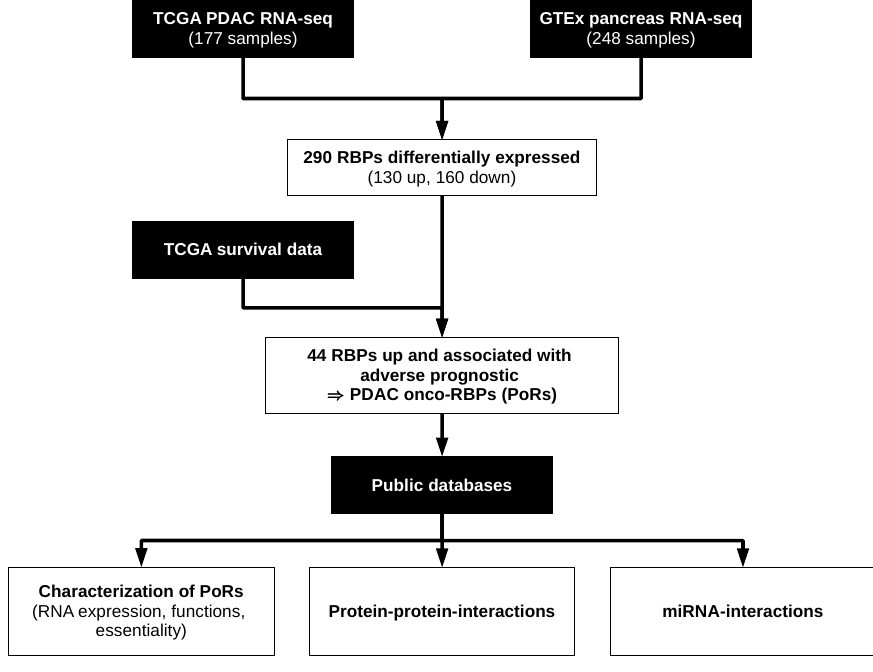
Figure 1. Analysis of pancreatic ductal adenocarcinomas (PDAC) onco-RNA binding proteins (RBPs). Flowchart depicting the analysis pipeline for the in silico identification and characterization of RBPs with oncogenic characteristics in PDAC using public data sets. Black boxes represent data sources, white boxes denote analysis